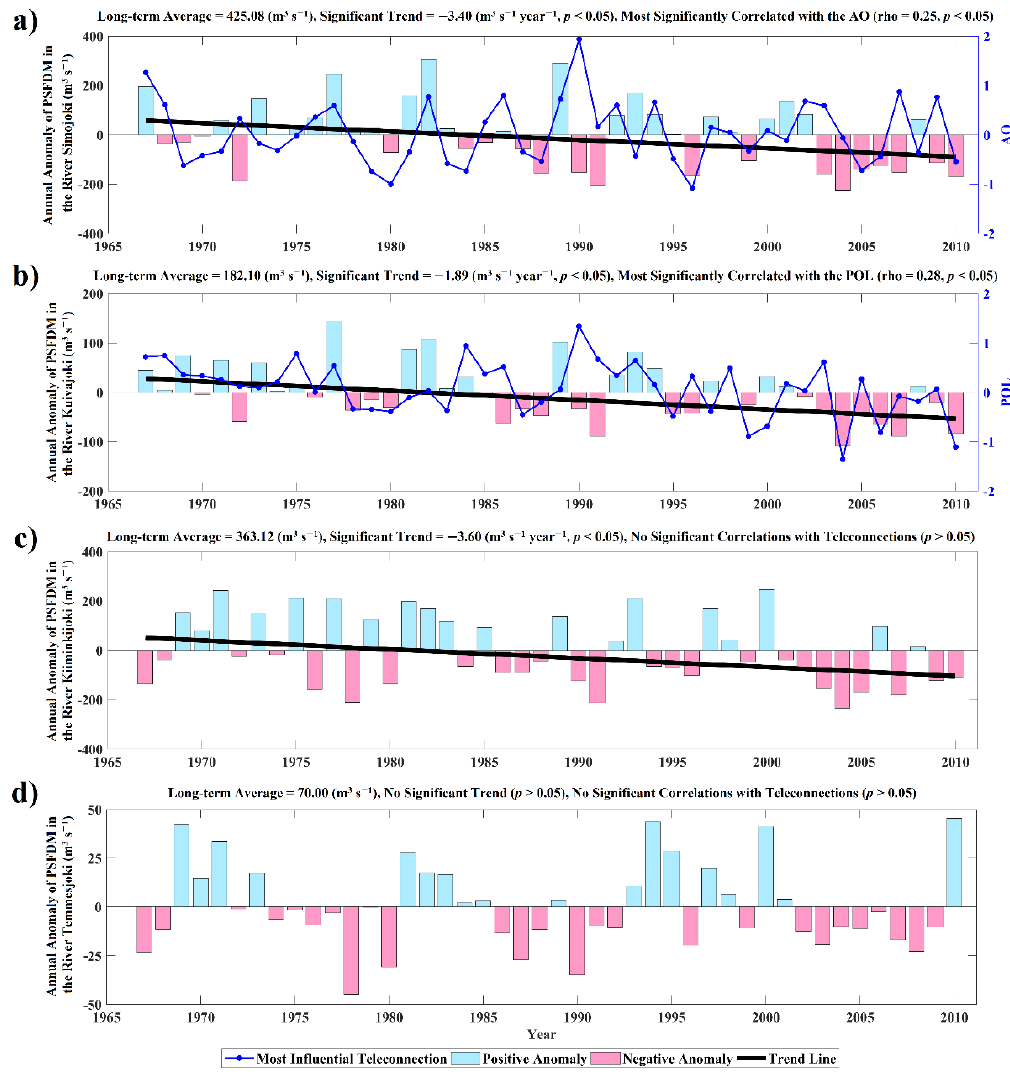
Figure 2. Annual anomalies with significant trend line ( p < 0.05) and the most influential springtime climate teleconnection for peak spring flood discharge magnitude (PSFDM) in the ( a ) Simojoki, ( b ) Kuivajoki, ( c ) Kiiminkijoki, and ( d ) Temmesjoki rivers across northern Finland during 1967 – 2011. Both Simojoki and Kuivajoki rivers experienced earlier PSFD in recent decades. The statistically significant decreasing trends in the PSFDT were about −0 .33 and −0 .3 (days